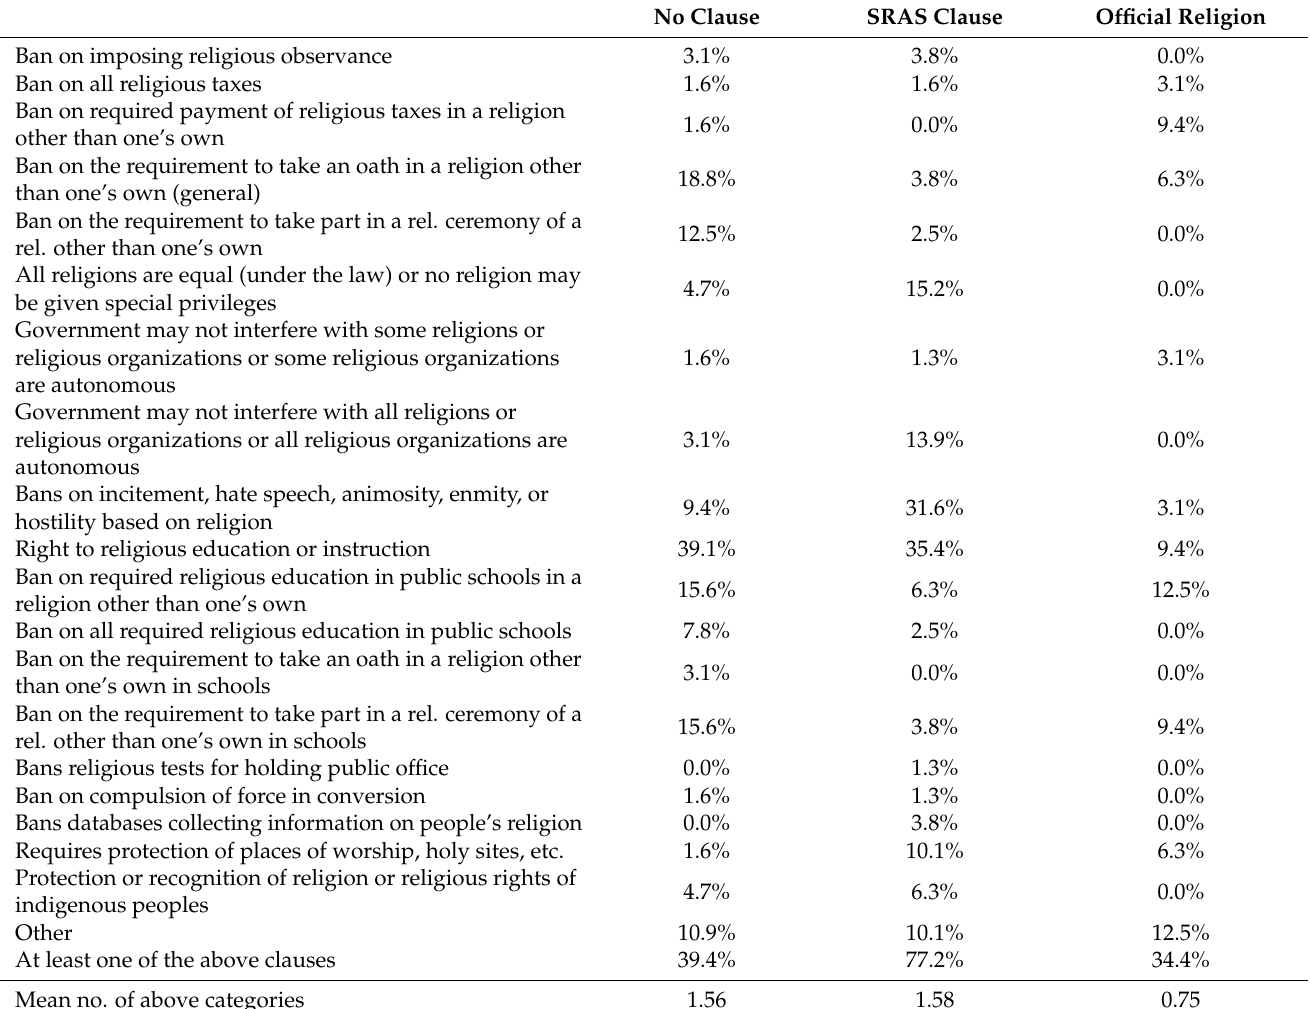
Table 12. Specific bans on government interference with religion in 2014. No Clause SRAS